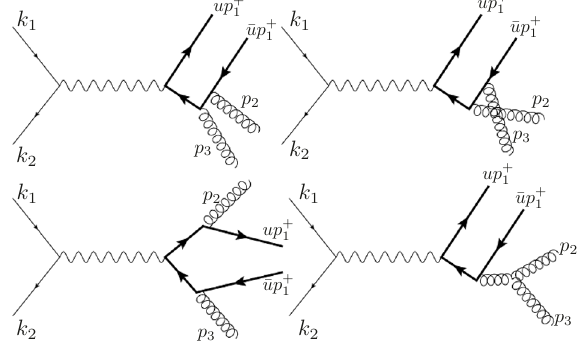
[ Q (cid:22) Q ( (cid:20) )] g . !